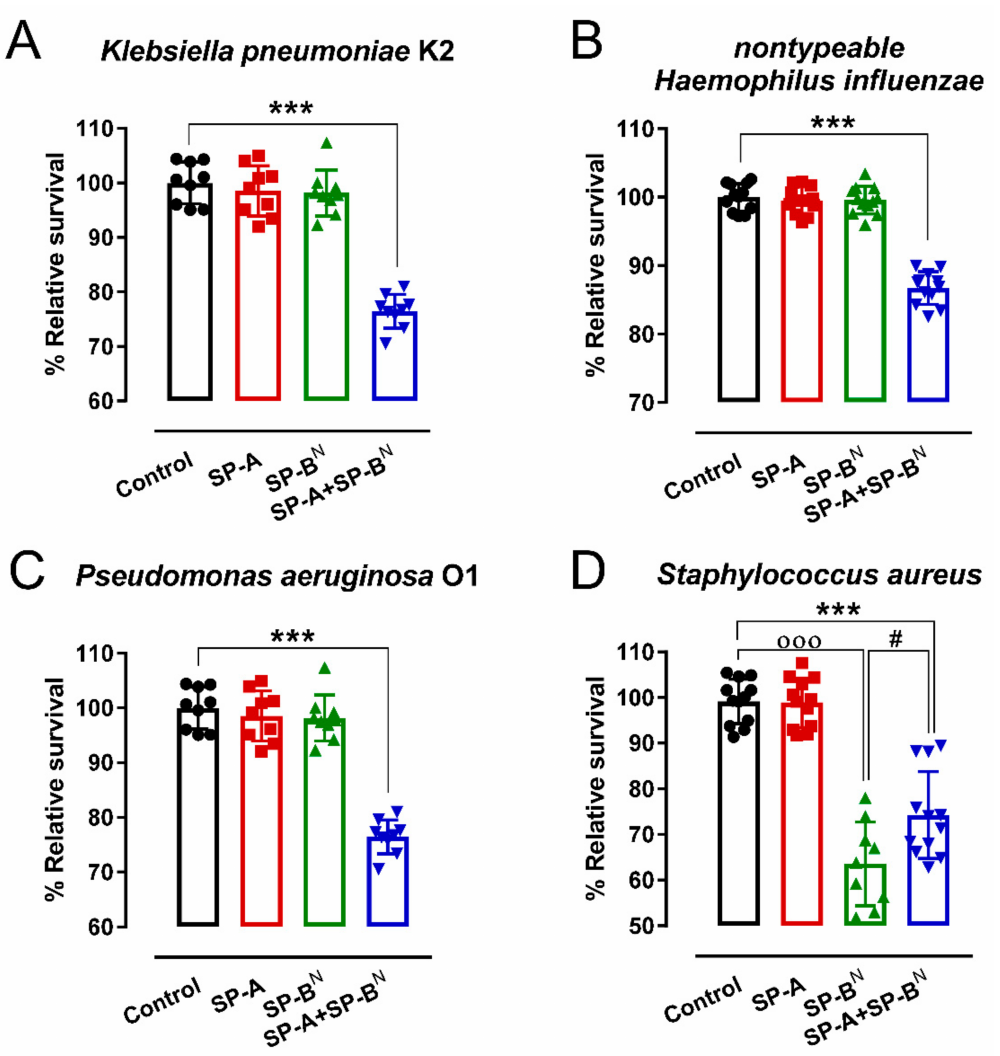
Figure 1. Antimicrobial activity of SP-A and/or SP-B N on K. pneumoniae K2 ( A ), non-typeable Haemophilus influenza ( B ), Pseudomonas aeruginosa O1 ( C ), and Staphylococcus aureus ( D ). The bacteria (10 5 CFU/mL) were incubated for 1 h at 37 ◦ C with SP-A and/or SP-B N in 20 mM phosphate buffer and 150 mM NaCl at pH 7. Then, the bacteria were plated on LB agar for CFU count after 18 h of incubation at 37 ◦ C. The results are shown as % viable bacteria (percentage of live colony counts compared with untreated control) and are the mean ± SD of at least nine experiments. A value of p < 0.001 was obtained for the one-way ANOVA, followed by the general multiple-comparison Bonferroni test: In ( A – C ), *** p < 0.001 when comparing SP-A+SP-B N treatment vs. the control and either the SP-A- or SP-B N -treated group. In ( D) , *** p < 0.001 when comparing SP-A+SP-B N treatment vs. the control and SP-A-treated groups; # p < 0.5 when comparing SP-A+SP-B N treatment vs. the SP-B N -treated group; ooo p < 0.001 when comparing SP-B N treatment vs. the control untreated